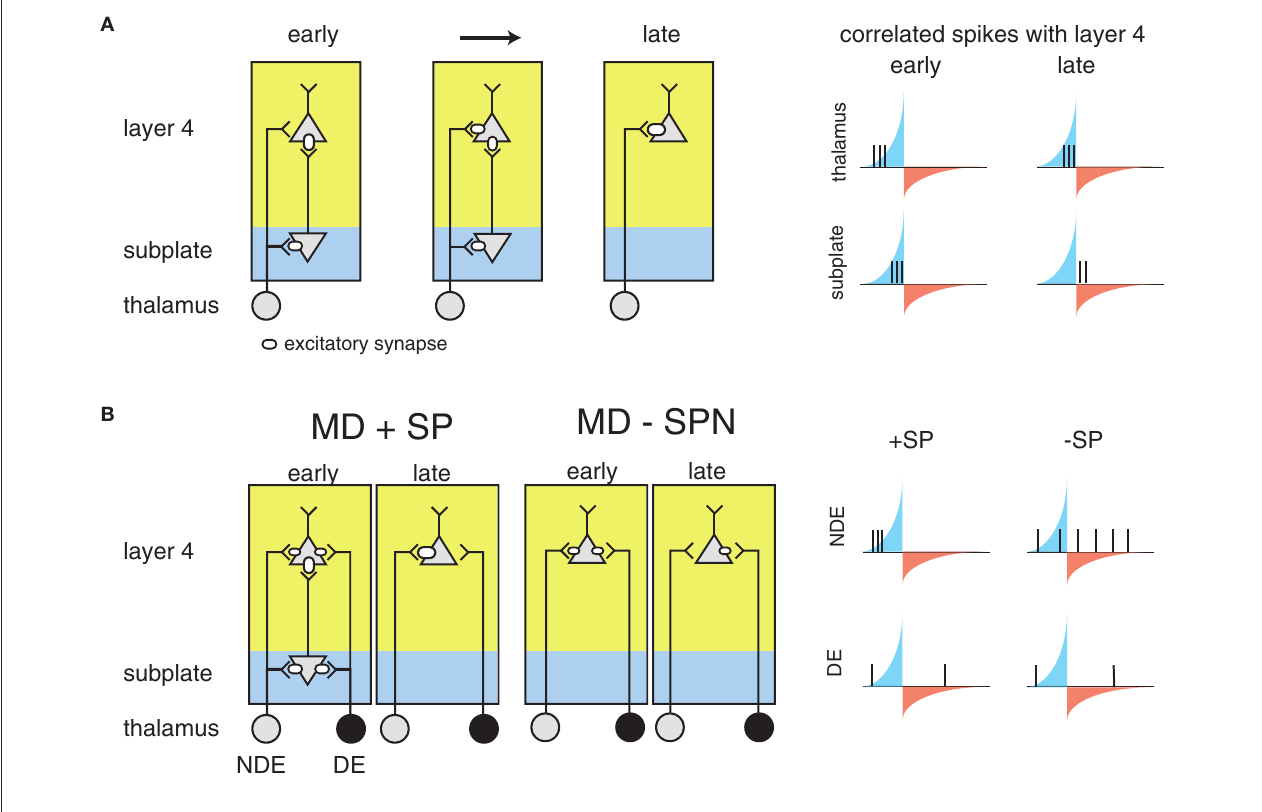
development. The potentiating and weakening windows of STDP rule are indicated in blue and red shading . (B) Effects of subplate neurons on the outcome of monocular deprivation (MD) on ocular dominance. Left panels show strengthening of the non-deprived eye (NDE) inputs and weakening of deprived eye (DE) inputs when subplate is present. Right panels show weakening of the NDE inputs and retention of DE inputs when subplate is absent, leading to paradoxical ocular dominance plasticity. Spike correlation at right show that layer 4 activity is uncorrelated with thalamic activity when subplate is removed, leading to selective weakening of